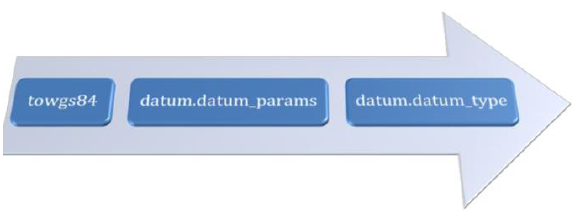
Figure 8. Datum Transformation Algorithm